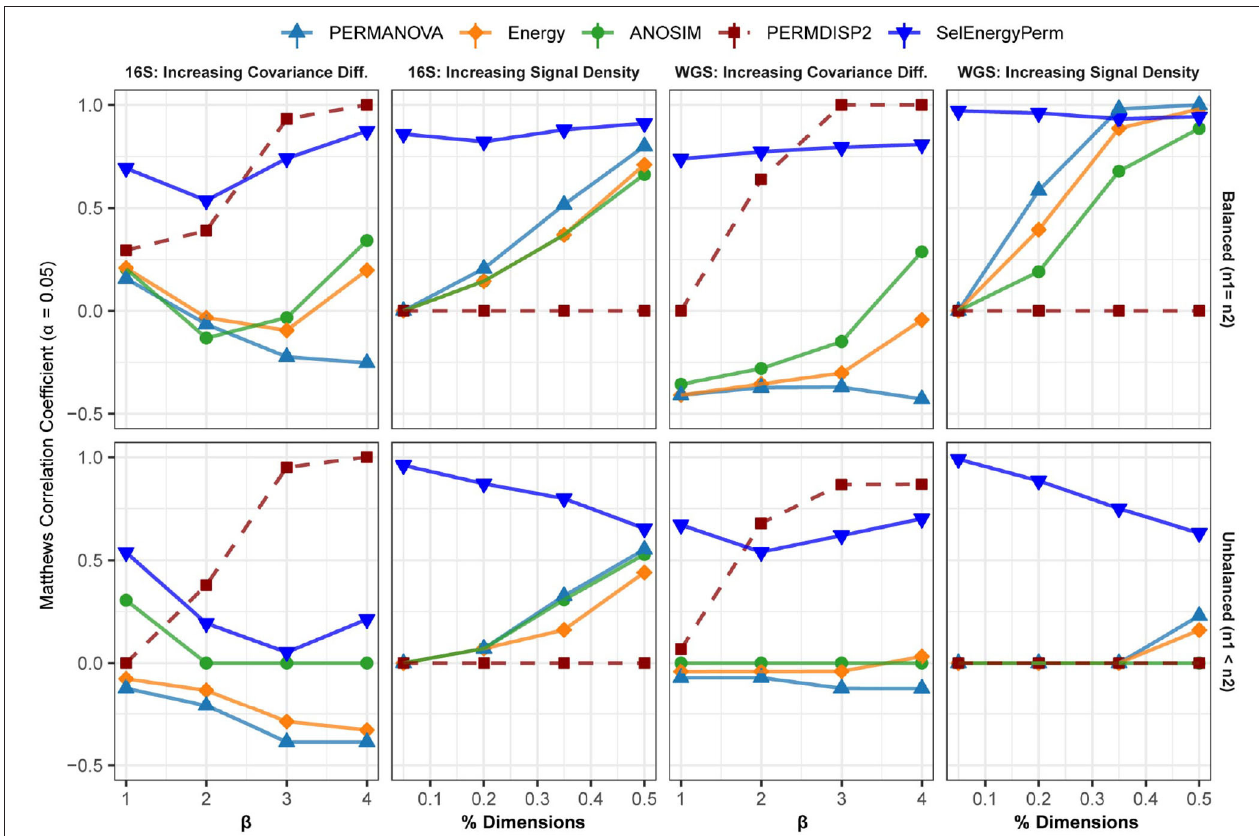
FIGURE 4 | Comparison of the Matthews Correlation Coefficient measuring the ability of each method to properly detect/reject associations in data simulated from real 16S and WGS data distributions in both balanced and unbalanced sampling designs. For each data type and scenario, datasets were generated to include data distributions that have either true between-group differences ( n 100) or no between-group difference ( n 100). Results from the PERMDISP2 (dashed line) = = procedure are displayed to indicate heterogeneity of variance between